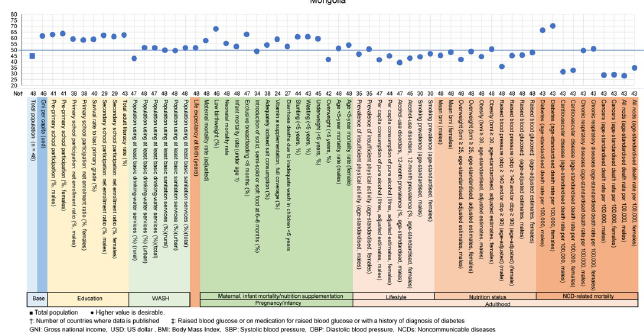
Fig 4. Country diagnosis by the deviation graph for